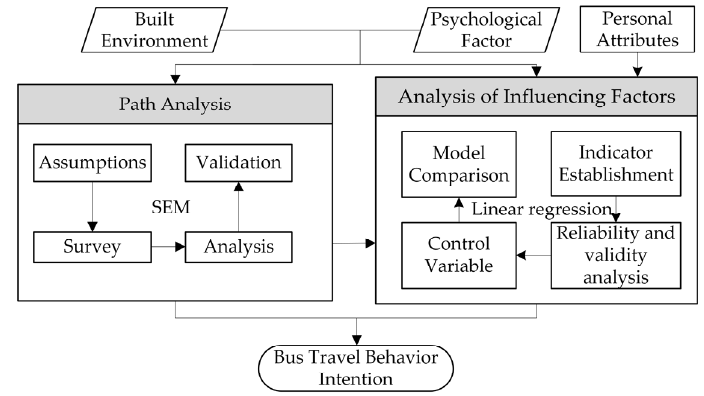
Figure 1. Research framework.